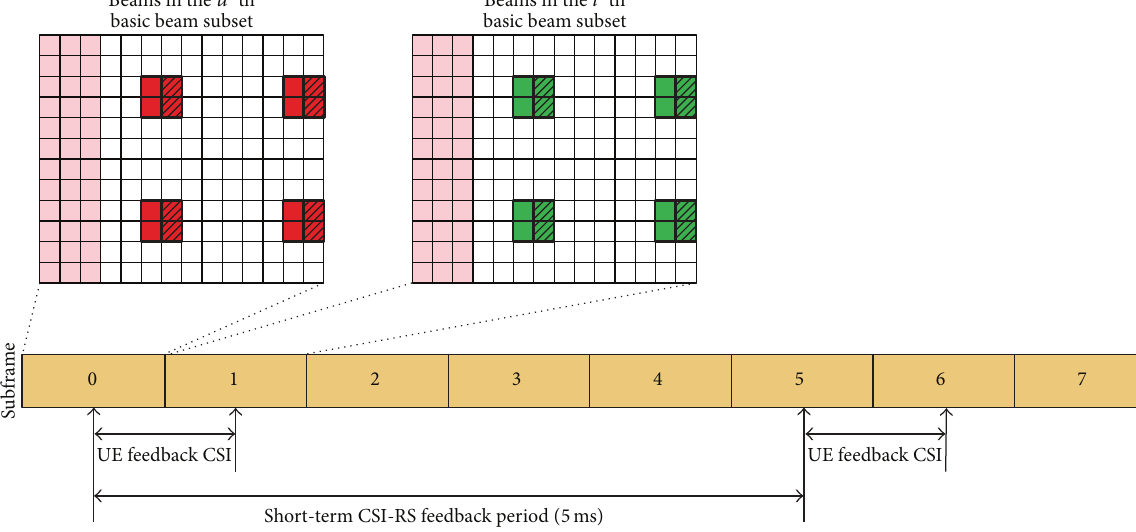
Figure 8: Schematic diagram of the configuration of short-term CSI-RS ports at the BS in MU-MIMO system.